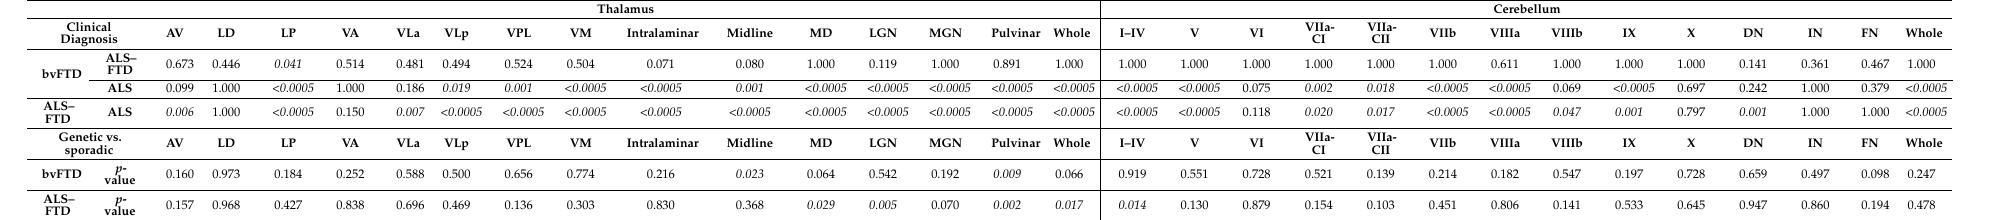
Table 3. Comparisons across diagnostic and genetic groups for the thalamic and cerebellar regions. Values denote p-values. Italics indicates significantly negative w-scores. Abbreviations. Thalamus: AV—anteroventral, VA—ventral anterior, LD—laterodorsal, VLa—ventral lateral anterior, MD—mediodorsal,